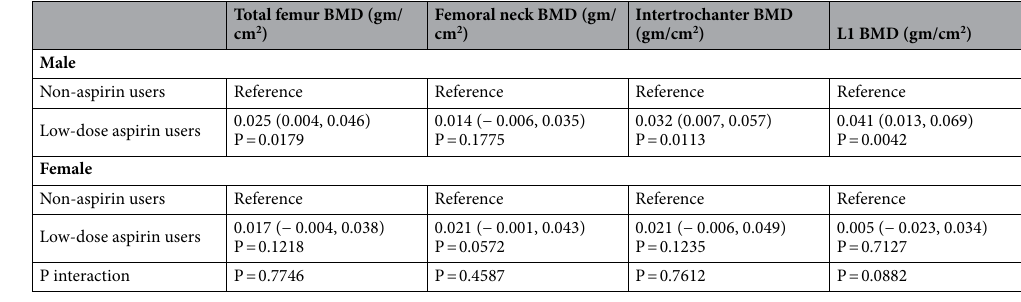
Table 3. Subgroup analysis was stratified by gender. Age, Race, Heart attack, Vigorous work activity, BMI, Hba1c, Education level, Ratio of family income to poverty, Fractures, Anti-osteoporotic, Prednisone or Cortisone, HS C-Reactive Protein, Smoking status, Serum Creatinine, Serum Uric acid, Alcohol consumption were adjusted.